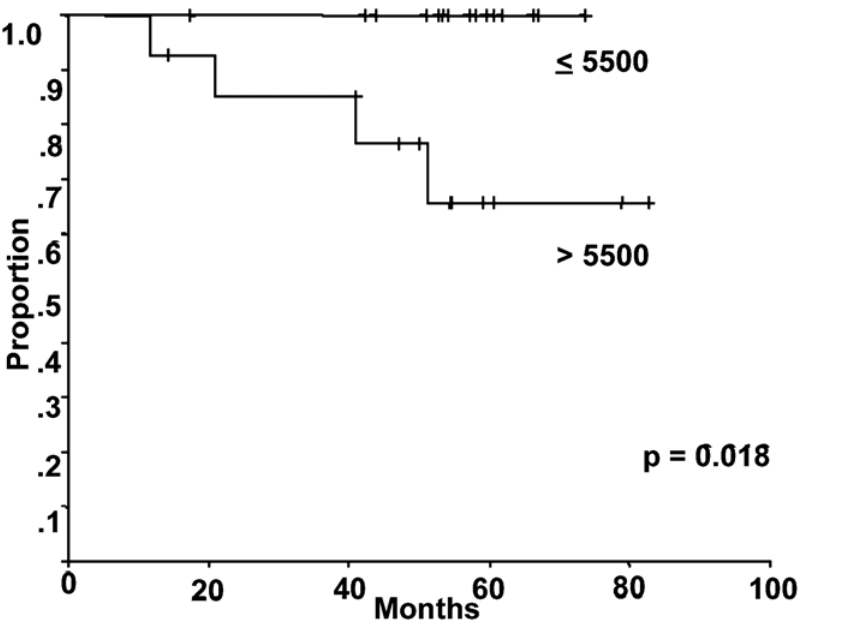
Figure 5 – Actuarial survival rate free from late urinary toxicity grades 2 and 3 after salvage conformal radiotherapy due to the radiation dosage of 5500 cGy in 50% of the bladder